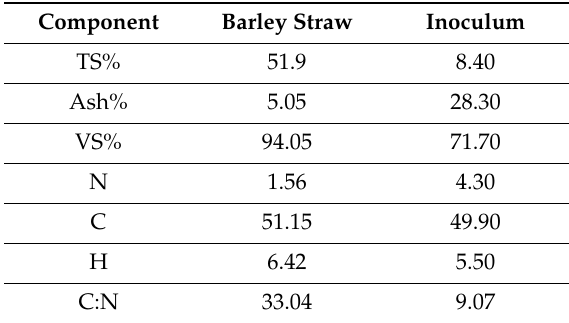
Table 5. The chemical compositions of barley straw.